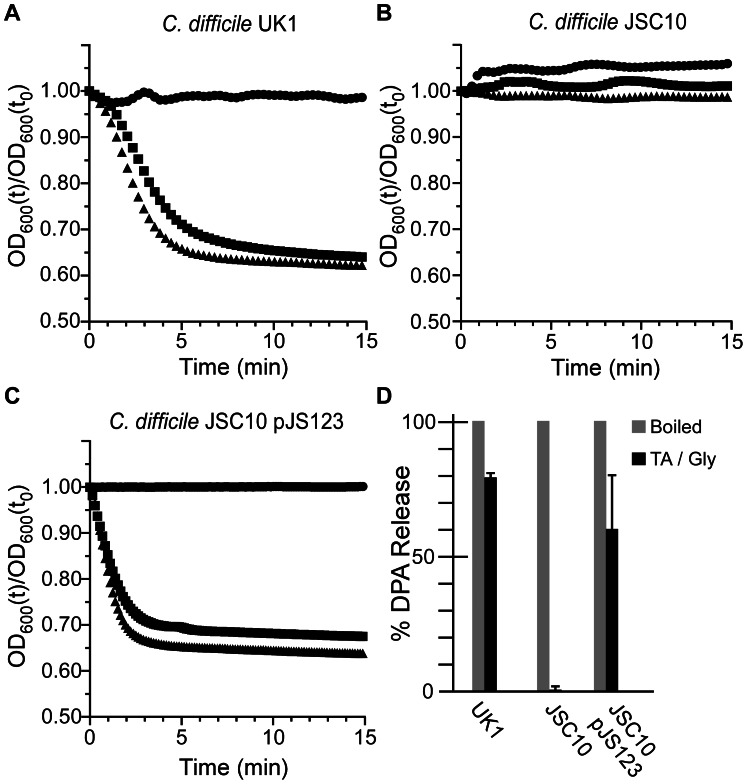

C.
difficile cspC is essential for bile acid-mediated spore germination.Purified C. difficile UK1 spores (A) or C. difficile JSC10 (cspC::ermB) spores (B) or C. difficile JSC10 (cspC::ermB) pJS123 (pcspBAC) (C) were suspended in BHIS medium (•) or BHIS medium supplemented with 5 mM TA (▪) or 50 mM TA (▴) and the initiation of germination was followed at A600. (D) DPA release from spores suspended in germination buffer supplemented with TA and glycine was analyzed at A270.